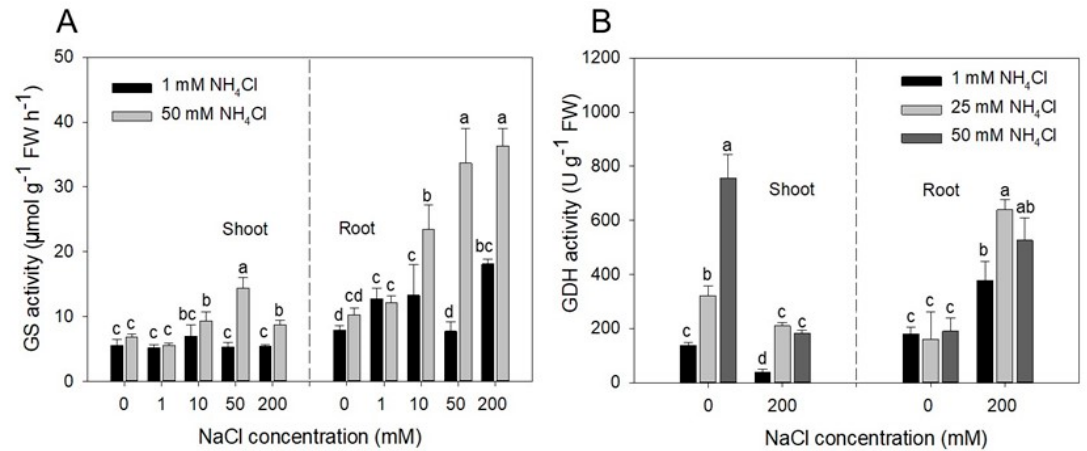
Figure 5. Activity detection of ammonium assimilation related enzymes under NaCl / NH 4 Cl treatments. ( A ) Glutamine synthase (GS) activity. ( B ) Glutamate dehydrogenase (GDH) activity in shoot and root tissues of Salicornia plantlets. Means with the same letter are not significantly different according to the Duncan’s test ( p < 0.05). Error bars represent the standard error.